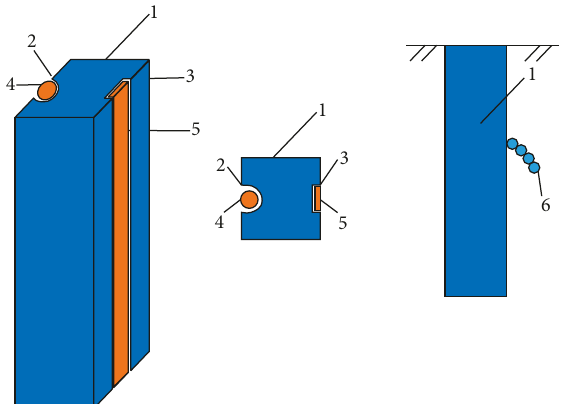
Figure 1: Sketch of the rigid-drainage pile [15]. 1: pile; 2: round groove; 3: square groove; 4: drain hose; 5: drainage material; 6: pore